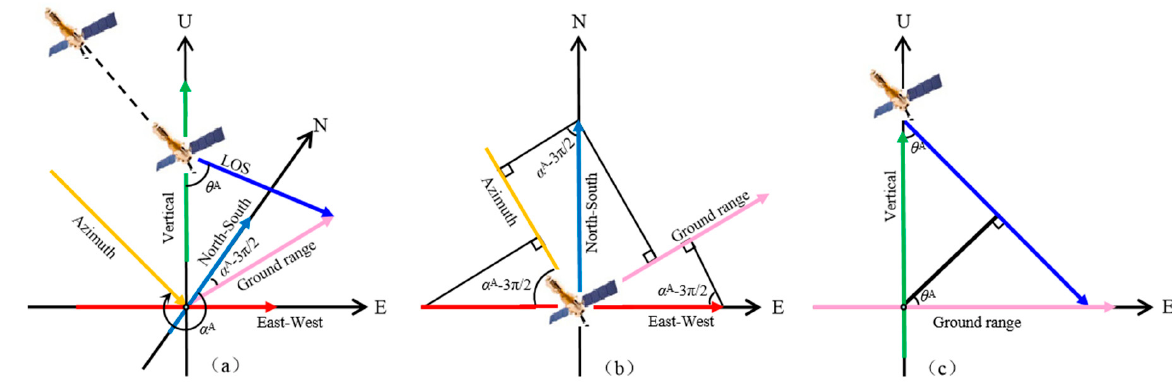
Figure 3. Geometric angle transformation of ascending image ( a ) Stereo, ( b ) vertical and ( c ) horizontal.